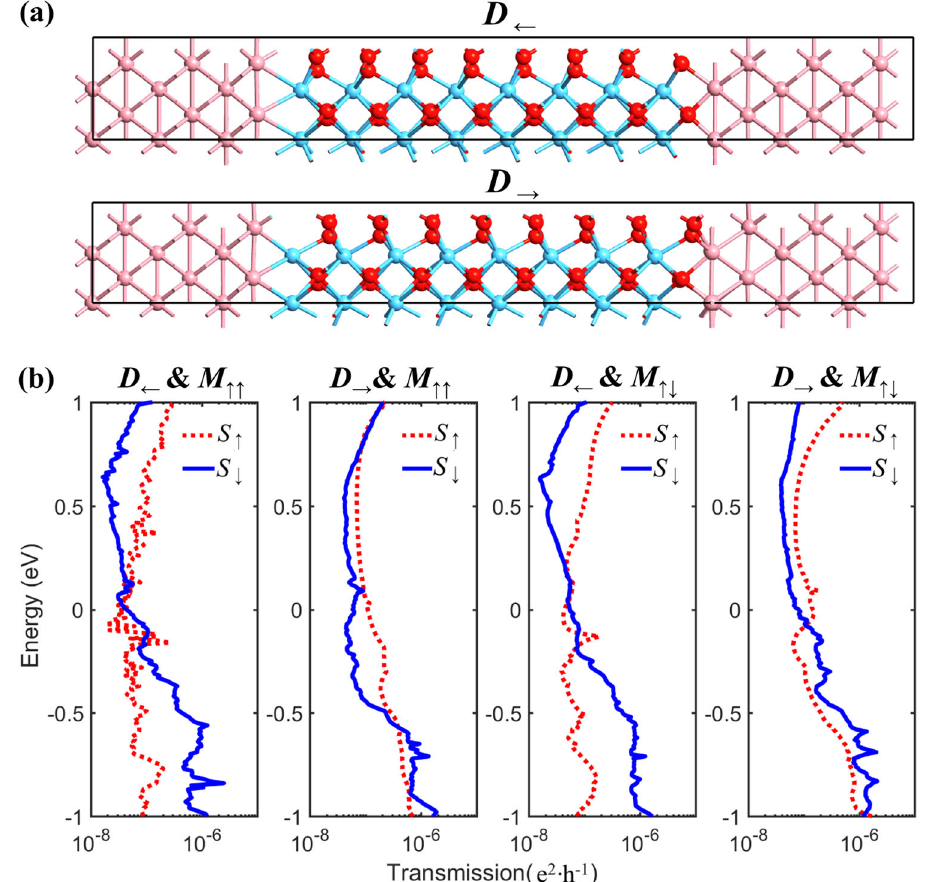
Fig. 7 Atomistic structures and transmissions of the Co/HfO 2 /Co junction with asymmetric interface terminations. a Atomistic structures and ( b ) transmissions of the Co/HfO 2 /Co junction with 2 nm HfO 2 and asymmetric interface terminations.